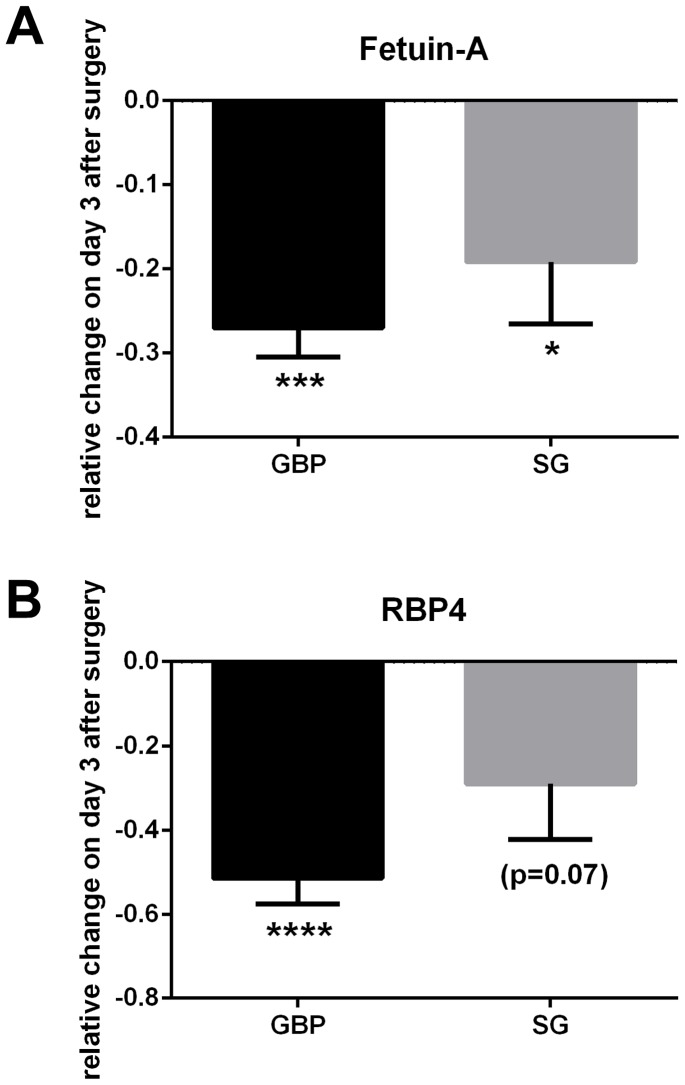
Validation of proteomic results for Fetuin-A and RBP4.Panel A: Fetuin-A levels were found by ELISA to decrease to some extent after both surgery types, however a more dramatic decrease was found after GBP. Panel B: significantly lower levels of RBP4 were detected by immunoassay after GBP only. Abbreviations: *, p<0.05; ***, p<0.001; ****, p<0.0001.